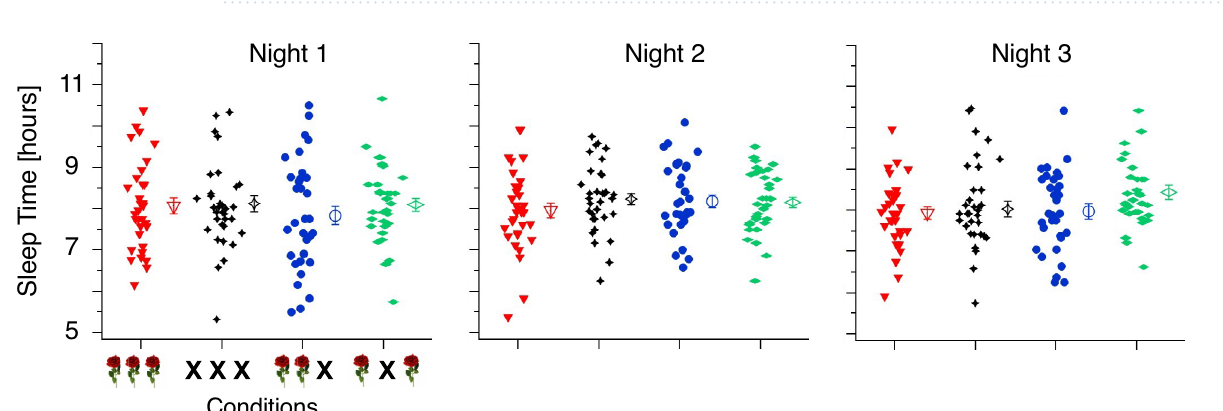
Figure 2. Results from Test 2. The left graph shows the data of all participants (small, filled icons). The right graph shows the outlier-corrected data, as described in the main text above. The different experimental conditions are shown on the x-axis (from left to right: LST in red, N in black, LS in blue and LT in green). The y-axis indicates the number of correctly recalled words. The open icons on the right of the icon clouds represent the grand means ± SEMs of the respective conditions. N: no odor stimulation; LS: odor stimulation during learning and sleep; LT: odor stimulation during learning and during the tests; LST: odor stimulation during learning, sleep and the tests.